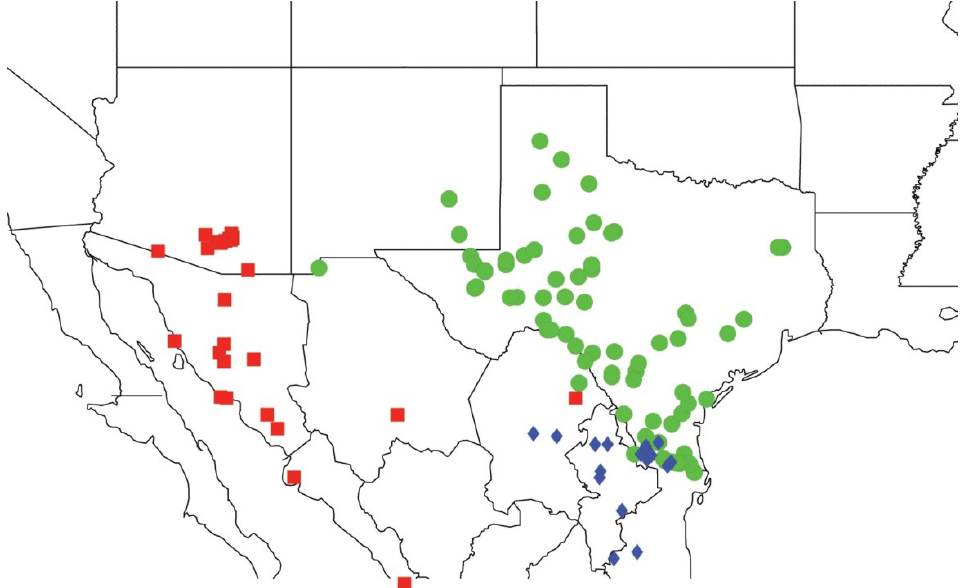
Figure 7. Distribution of Dicerprocta lata (blue diamonds), D. texana (green circles) and D. knighti (red